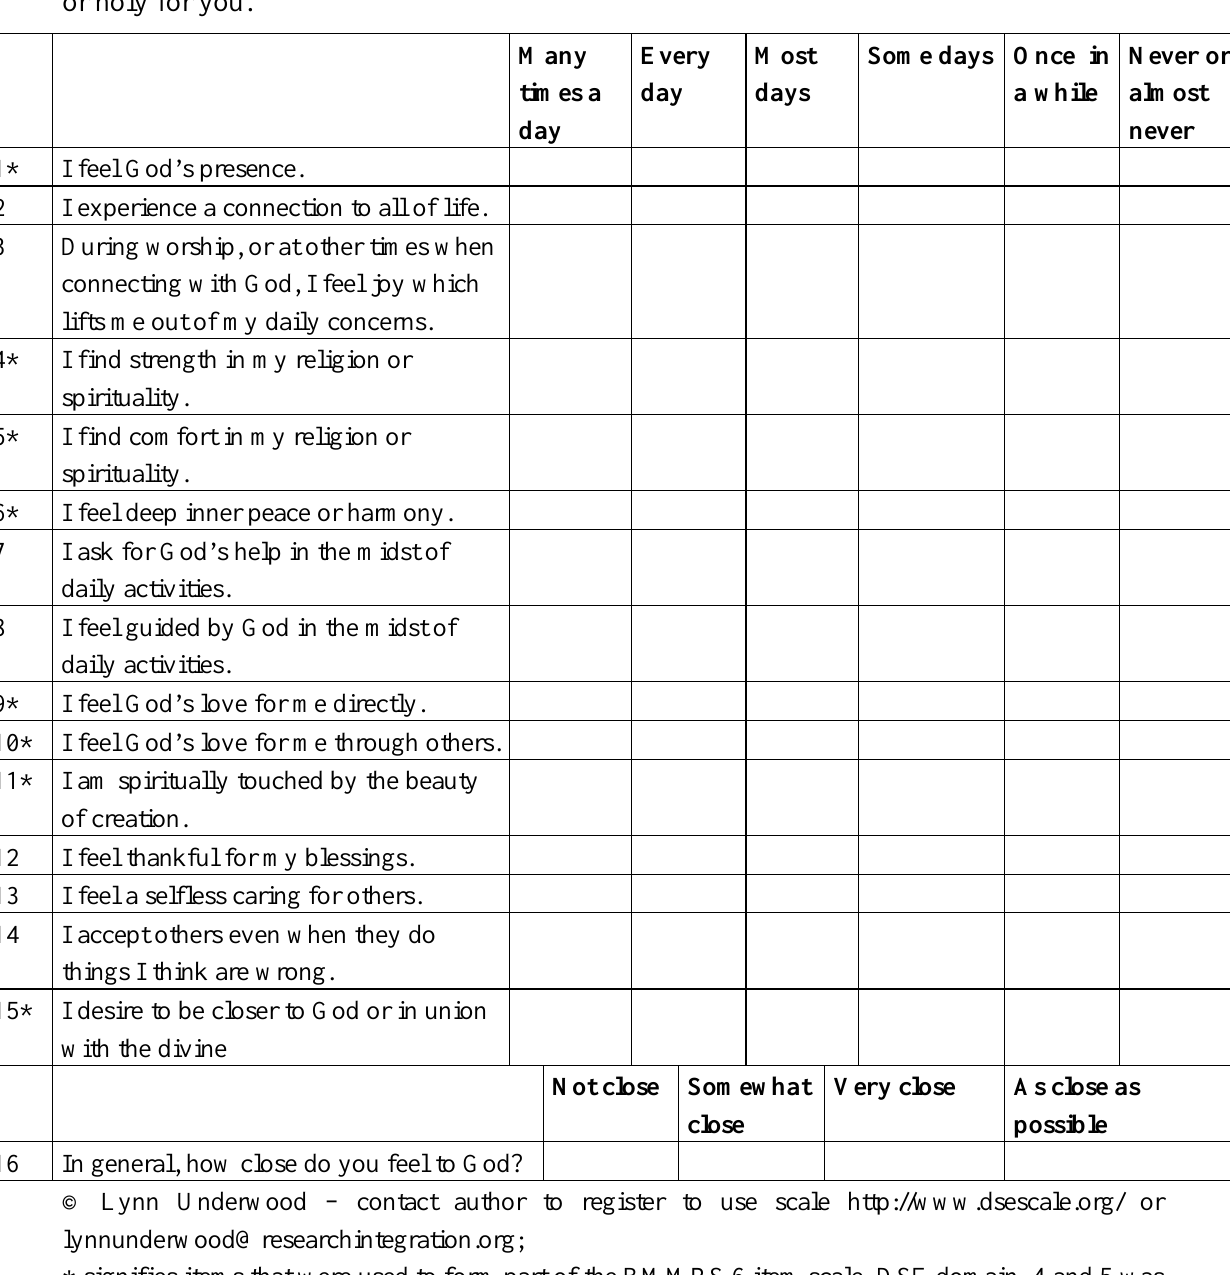
Table 1. Daily Spiritual Experience Scale (with item numbers added). Introduction: “The list that follows includes items you may or may not experience. Please consider how often you directly have this experience, and try to disregard whether you feel you should or should not have these experiences. A number of items use the word ‘God.’ If this word is not a comfortable one for you, please substitute another word that calls to mind the divine or holy for you.”